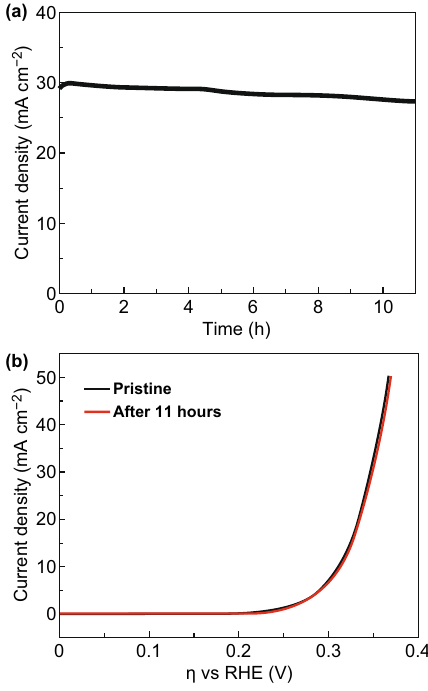
Figure 4 Electrochemical stability tests. a Current density measured at η = 345 mV (vs. RHE) as a function of time. b OER polarization curves of 2.27-nm La 2 O 3 @NP-NS before and after 11-h